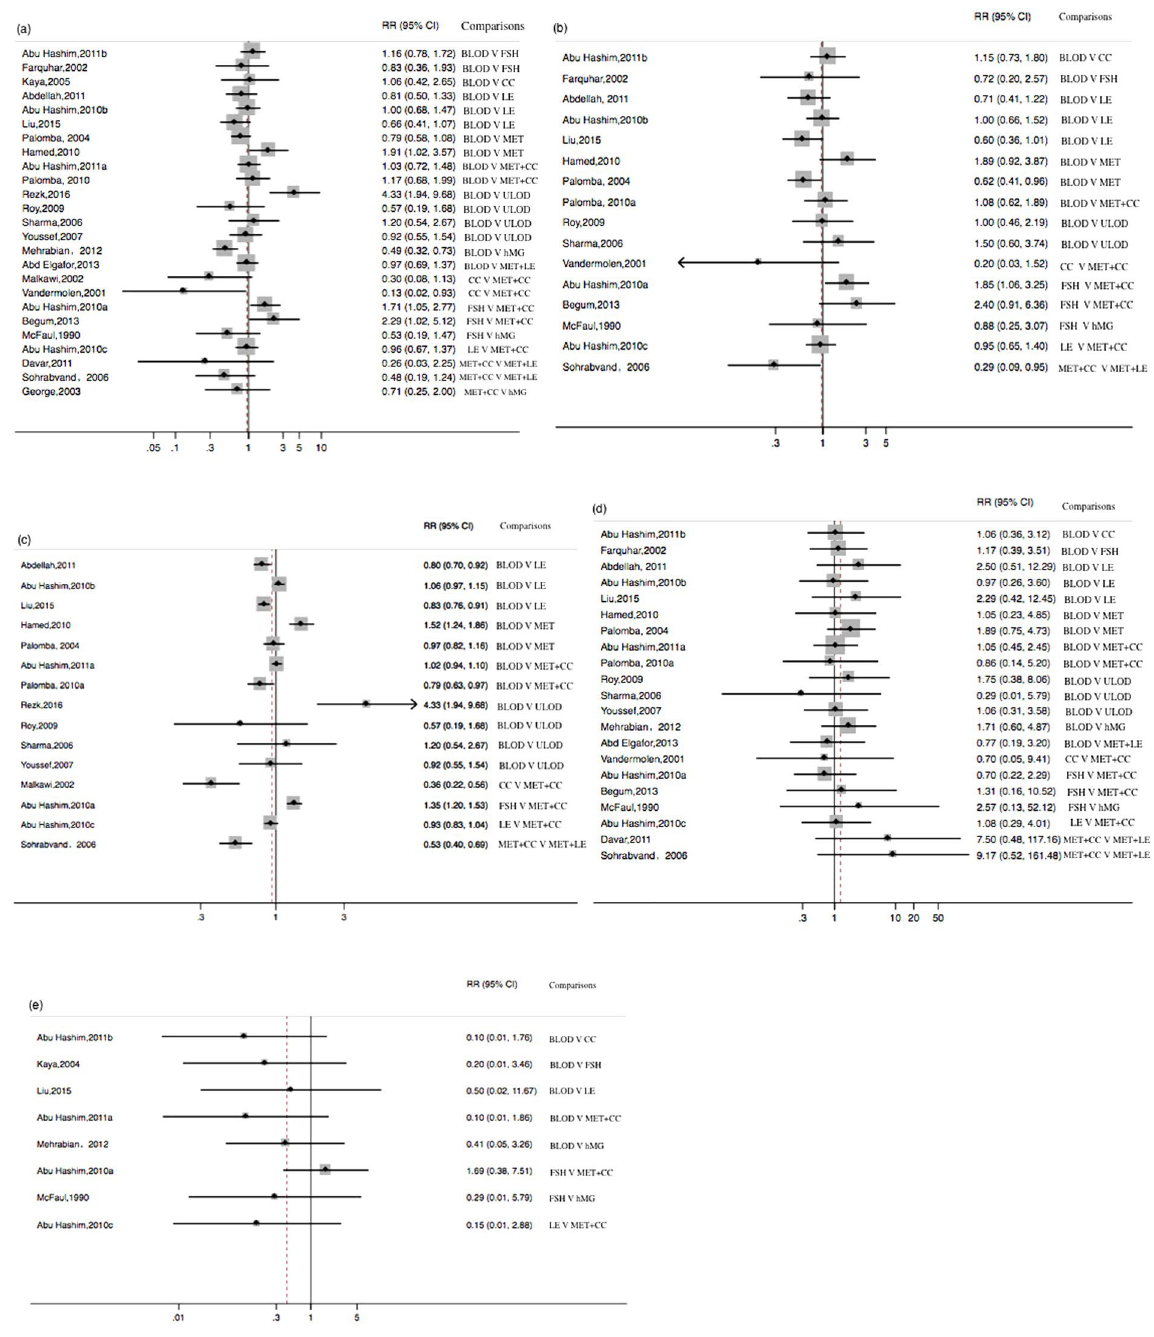
Figure 4. Forest plots showing effects of treatments for all direct comparisons. ( a ) pregnancy rate per ITT. ( b ) live birth rate per ITT. ( c ) ovulation rate per cycle, for BLOD verus ULOD: ovulation rate per ITT. ( d ) abortion rate per pregnancy. ( e ) multiple pregnancy rate per pregnancy. CC: clomiphene citrate, MET: metformin, LE: letrozole, FSH: follicle-stimulating hormone, hMG: human menopausal gonadotropin, MET + CC: metformin combined with clomiphene citrate, MET + LE: metformin combined with letrozole, ULOD: unilateral laparoscopic ovarian drilling and BLOD: bilateral laparoscopic ovarian drilling, CI: confidence